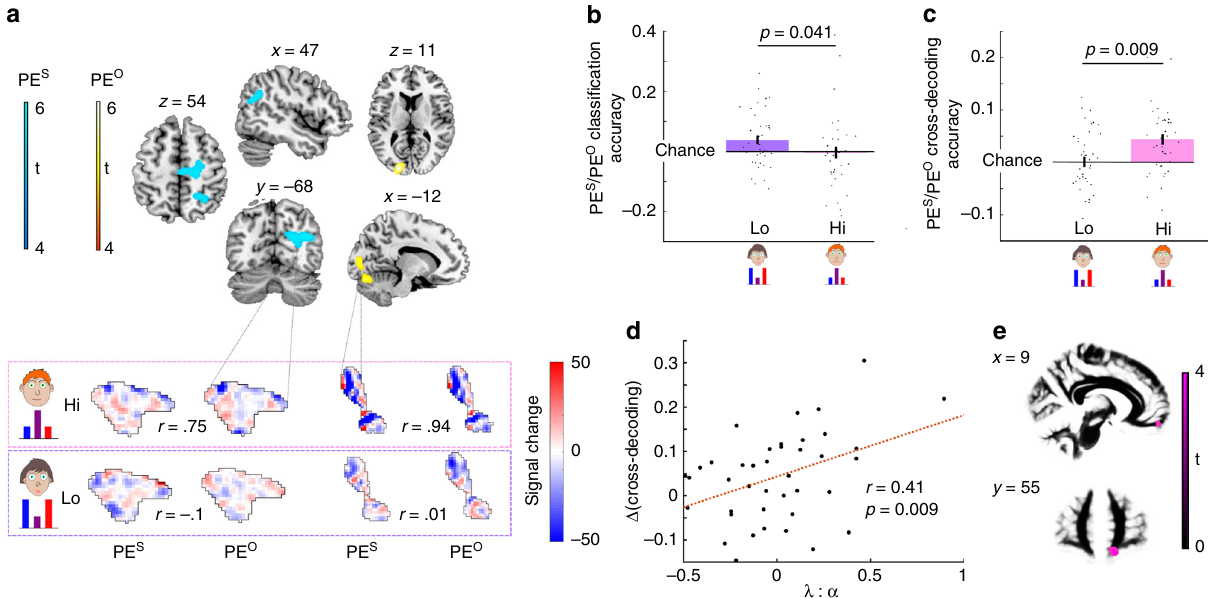
Fig. 4 Representations of PEs adapt with behavioural training. a Clusters of voxels where BOLD signal covaried with |PE|, either Self-attributed (PE s ) or Other-attributed (PE o ), from a searchlight analysis, using two one-sided t-contrasts on n = 40 independent subjects. Clusters were de fi ned with a cluster- forming threshold of p < 0.001. Only clusters large enough to survive FWE-correction at p < 0.05 are displayed (top). BOLD signal was extracted from these clusters and patterns of PE-related activity were compared for Self- and Other-attributed signals for the Lo-Share and Hi-Share contexts. Exemplar trial patterns are shown from a single subject. The ‘ signal change ’ refers to the difference in BOLD signal between a trial with a large PE and a trial with a small PE (see Methods). Patterns for PE self and PE other are more similar for the Hi-Share context than the Lo-Share context (bottom). b Decoding performance (cross-entropy below chance) when classifying PE activity patterns as Self- or Other-attributed. Classi fi cation accuracy was signi fi cantly higher in the Lo-Share context than the Hi-Share context. n = 40 independent subjects. Paired two-sided t-test: t(39) = 2.1, p = 0.041. c Decoding performance when predicting |PE other | after training on |PE self | and vice versa. Cross-decoding accuracy (Fisher Z-transformed correlation) was signi fi cantly higher in the Hi-Share context than the Lo-Share context. n = 40 independent subjects. Paired two-sided t-test: t(39) = 2.75, p = 0.009. d The difference in cross-decoding performance shown in c , is positively correlated with the ratio of leak to learning rate (parameters derived from the Hi-Share context). This indicates a relationship between neural Self-Other mergence and behavioural Self-Other mergence. n = 40 independent subjects. Pearson correlation: r = 0.41, p = 0.009. e Cluster of voxels where myelin-related MT covaried with the difference in cross-decoding shown in c , overlaid on white matter. Clusters were de fi ned with a cluster-forming threshold of p < 0.001. Only clusters that were large enough to survive FWE-correction at p < 0.05 are displayed. All error bars denote s.e.m. Source data are provided as a Source Data fi